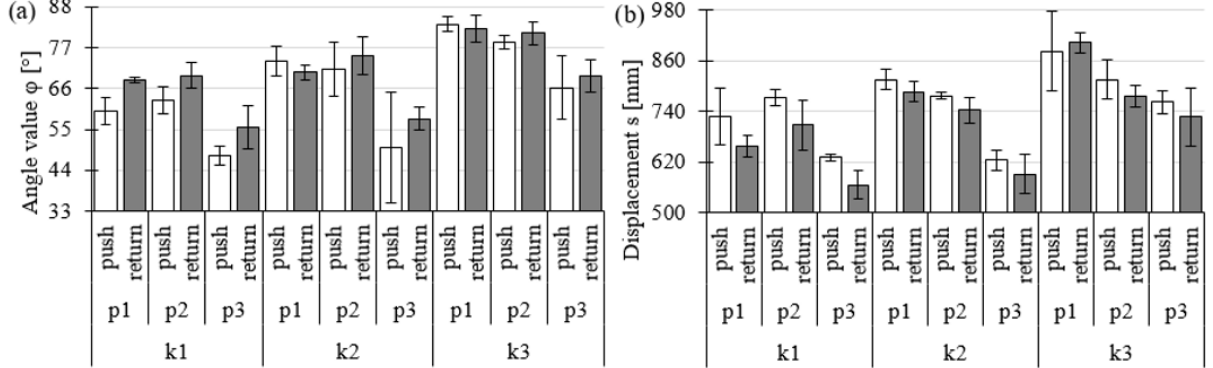
Figure 13. Designated values: ( a ) total angle of rotation ϕ of wrist marker (ID1) and ( b ) total displacement s of wrist marker (ID1).